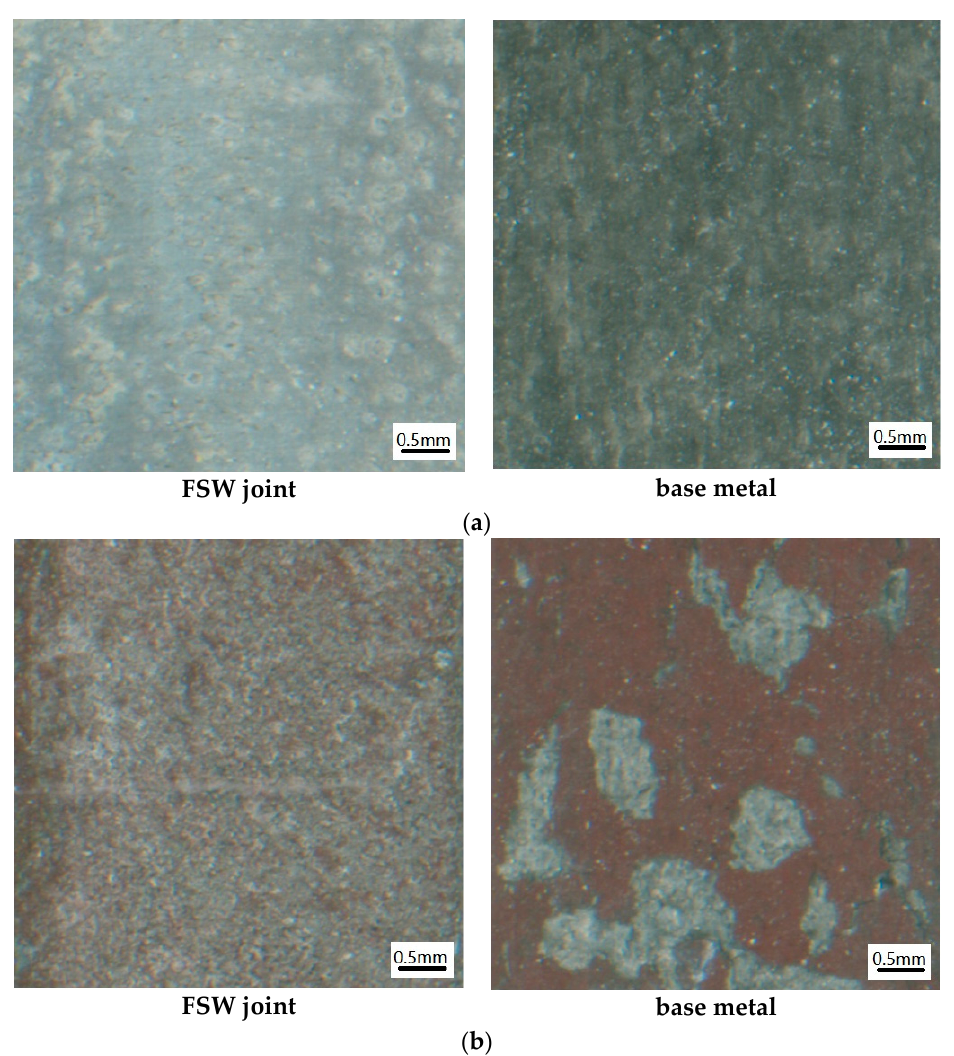
A comparison of macroscopic morphology due to pure electrochemical corrosion: ( a ) duration of exposure to environment is 8 h at applied stress ( σ ) of 0 MPa; ( b ) duration of exposure to environment is 24 h at applied stress ( σ ) of 0